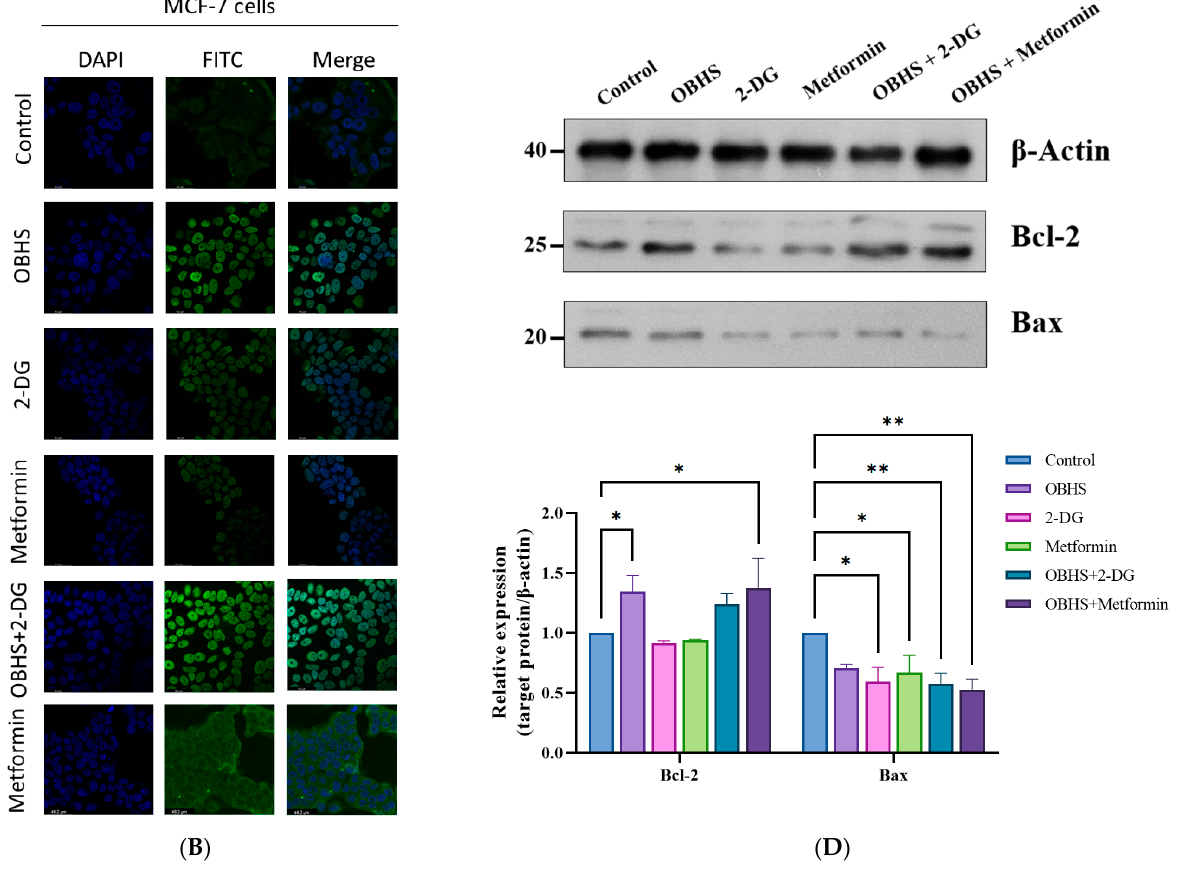
Figure 5. OBHS promoted lactate-induced cell apoptosis caused by the increased ratio of ROS in MCF-7 cells. ( A ) OBHS led to a reduction in cell viability in MCF-7 cells. ( B ) Representative images of TUNEL staining. TUNEL-positive apoptotic cells were shown in green and DAPI nuclear staining was showed in blue (scale bar = 46.2 µm). ( C ) The cells were treated with 15 µM OBHS, 10 µM 2-DG (pink bars), 10 µM metformin (green bars), a combination of metformin and OBHS (dark purple bars), or 2-DG and OBHS (lake blue bars) for 24 h, and we collected the supernatant of cell lysate by repeated freezing and thawing lyses the cells to measure LDH1 concentration. ( D ) OBHS treatment and the combinations promoted apoptosis in MCF-7 cells. ( E ) Both OBHS treatment and SLC2A1 knockdown led to an increased ROS level in MCF-7 cells. Data are expressed as the mean ± SEM. n.s., not signi fi cant. p values are indicated. * p < 0.05, ** p < 0.01, and **** p < 0.0001.